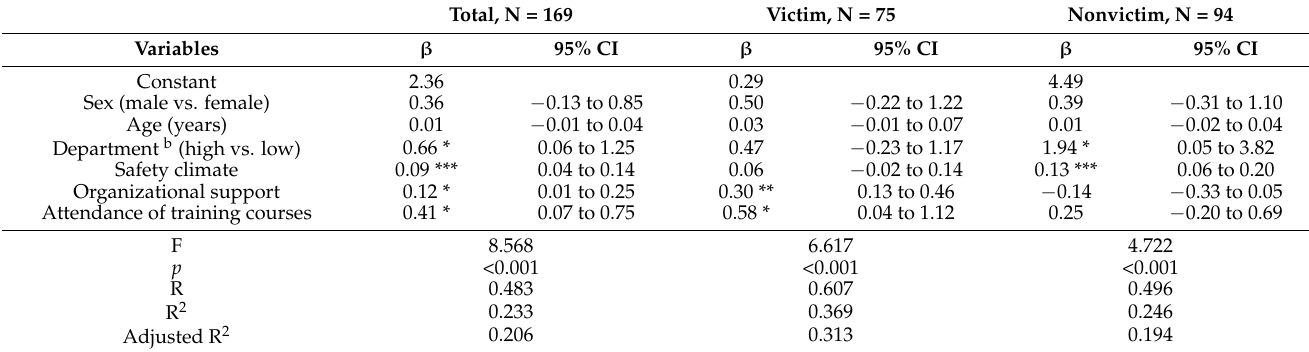
Table 3. Multiple liner regression of physicians’ confidence in handling WPV a and associated